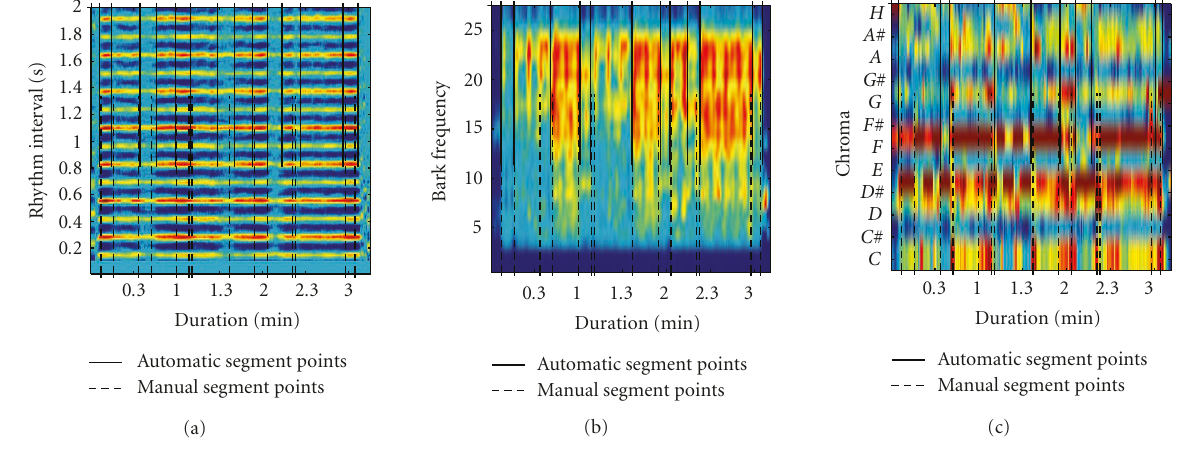
Figure 8: (a) Rhythm, (b) timbre, (c) and chroma of Whenever, Wherever